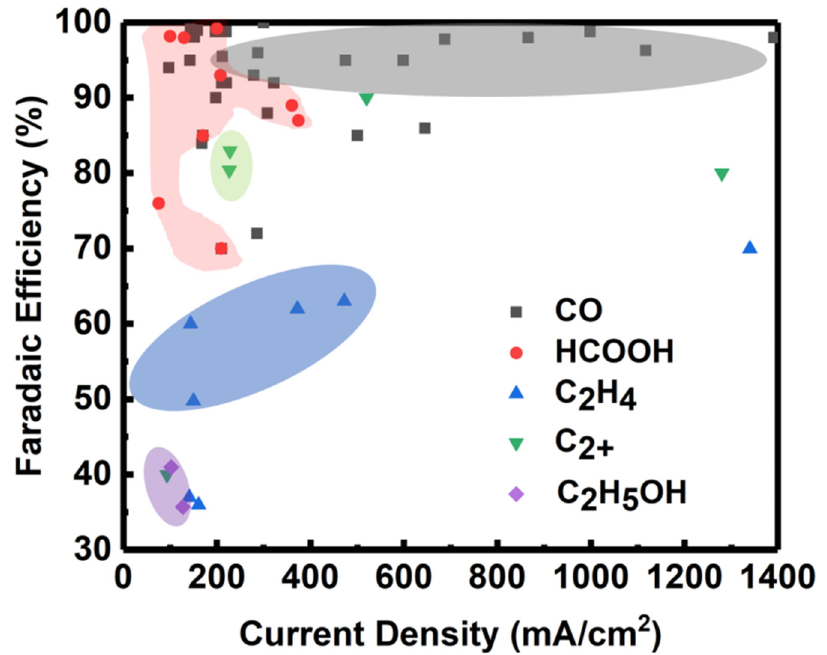
Figure 7. Faradaic efficiency and corresponding current density for different CO 2 ER